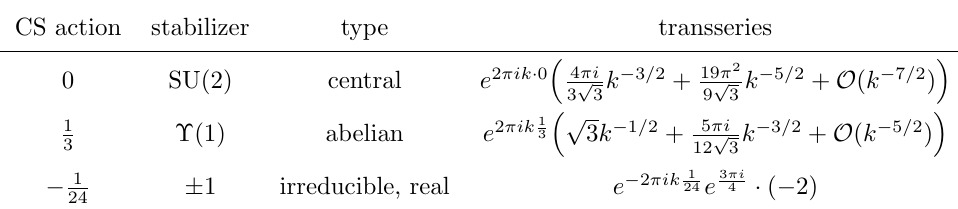
2; 1 ; 2 ; 2 ) = S 3 ( 3 ‘ ) up to an (cid:0) 3 1 2 3 3 (cid:0)